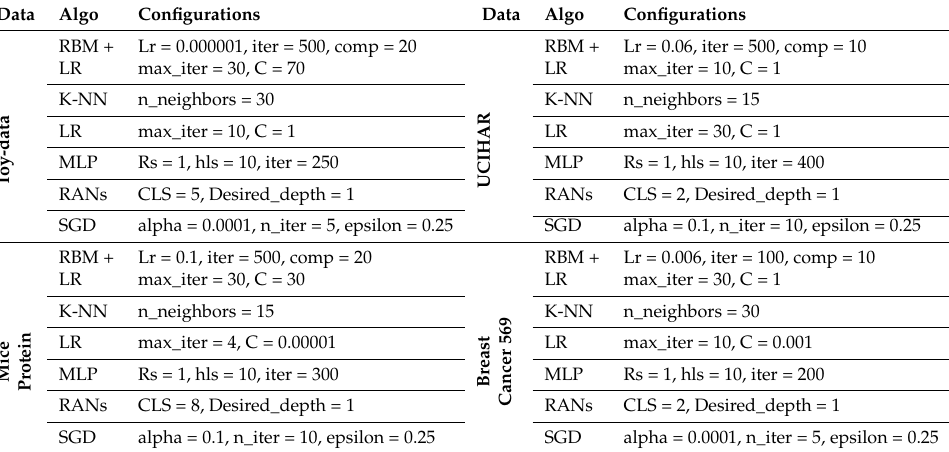
Table A5. Dataset specific configuration details of